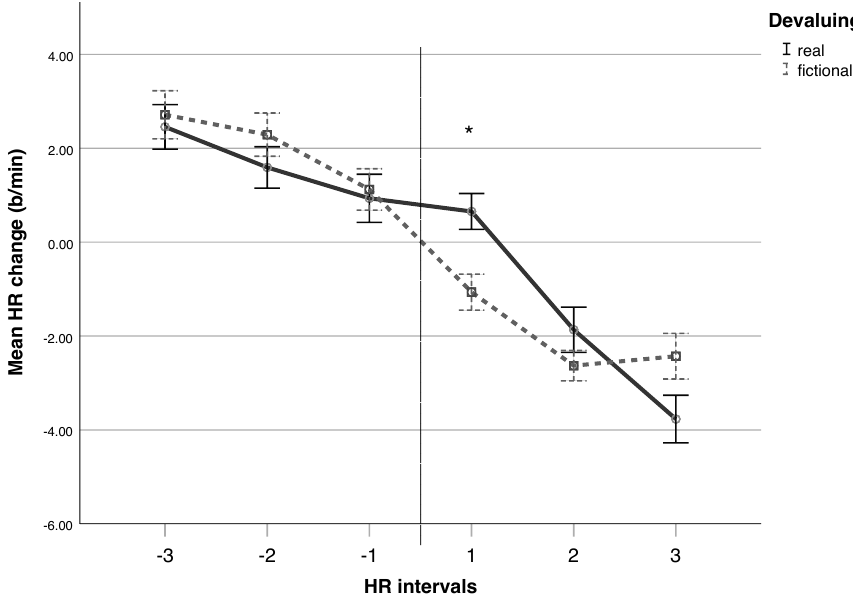
Figure 4. Phasic HR response to social rejection (devaluing). Here, 2 s HR intervals from 6 s before the onset of a rejection ( − 3, − 2, and − 1) to 6 s after the onset of a rejection (1, 2 and 3). The time of the rejection onset is presented as the vertical line. N = 38. Error bars: +/ − 1 SE (* p < 0.05, FDR <